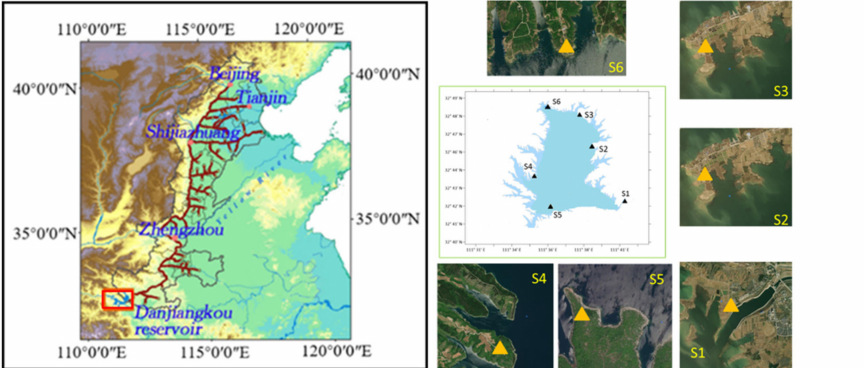
Figure 1. Sampling point position and automatic sampler.